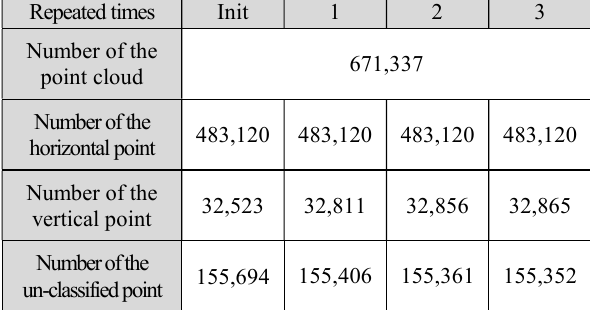
Table 2. Number of points classified into three